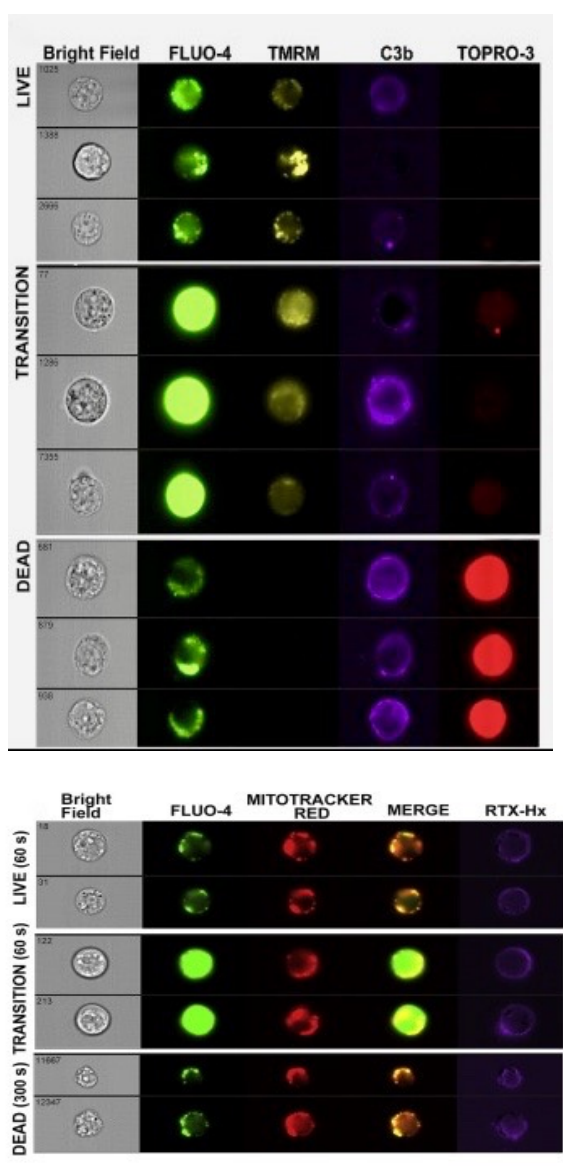
Figure 10. Four-color kinetic analyses by HRDI of the transition-state intermediate. Delineation of discrete steps in CDC: Four-color kinetic analyses by multispectral fluorescence imaging. Top panel: Images of representative 7D8-Hx treated cells that are either alive, in transition, or are dead. Bottom panel: Representative images for cells reacted with Al647 RTX-Hx (E345R) after 60 s (live and transition) or after 300 s (dead). The cells were presumed to be dead by 300 s based on the